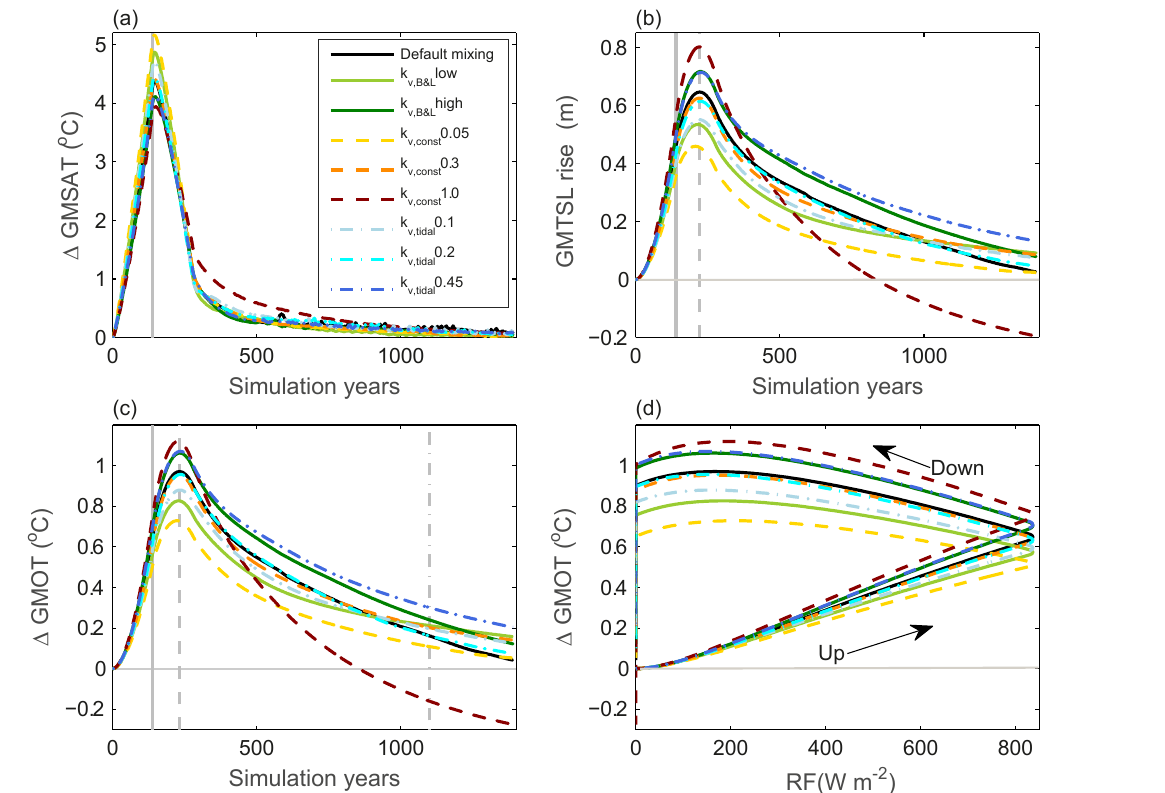
Figure 1. Changes in global mean surface air temperature (a) , global mean thermosteric sea level (b) , and global mean ocean temperature (c) relative to year 0 over time and change in GMOT versus radiative forcing (d) . The solid vertical grey line in panels (a) , (b) , and (c) indicates the time of peak atmospheric CO 2 concentration (quadrupling of pre-industrial levels, year 140). The dashed grey line in panel (b) and (c) indicates the time GMTSL and GMOT reach maximum values. The dot-dashed grey line in panel (c) is the time Figs. 2 and 3 refer to (year 1100). Horizontal grey lines mark